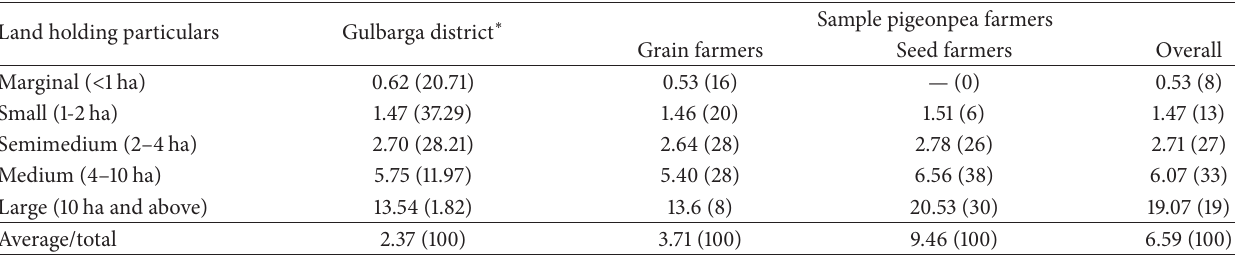
Table 2: Average land holding of sample pigeonpea farmers.